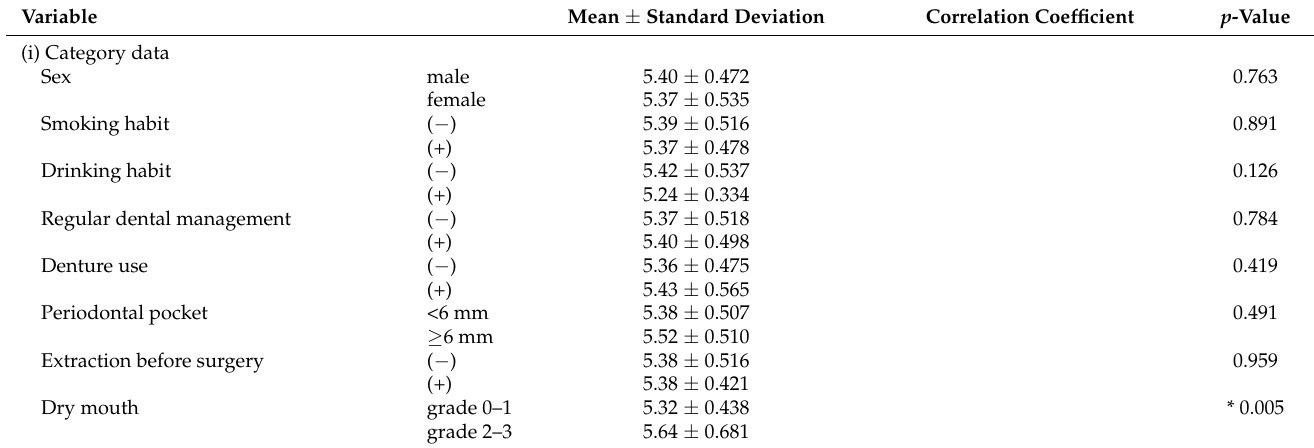
Table 2. Factors related to the number of bacteria in saliva before surgery (univariate